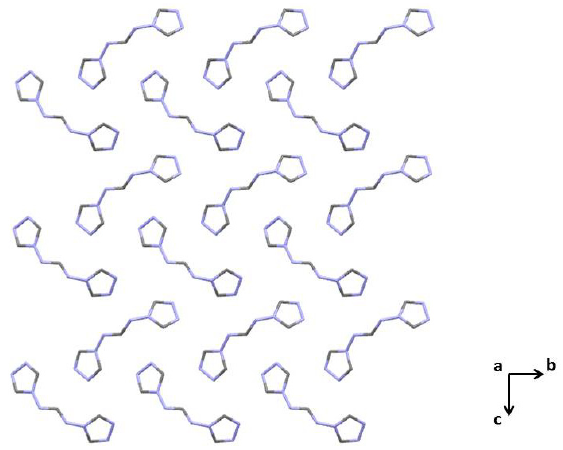
Figure 1. Thermal ellipsoid (50%) plot of L along the a -axis. The nitrogen and carbon atoms are depicted in blue and grey, respectively. H-atoms were omitted for clarity.